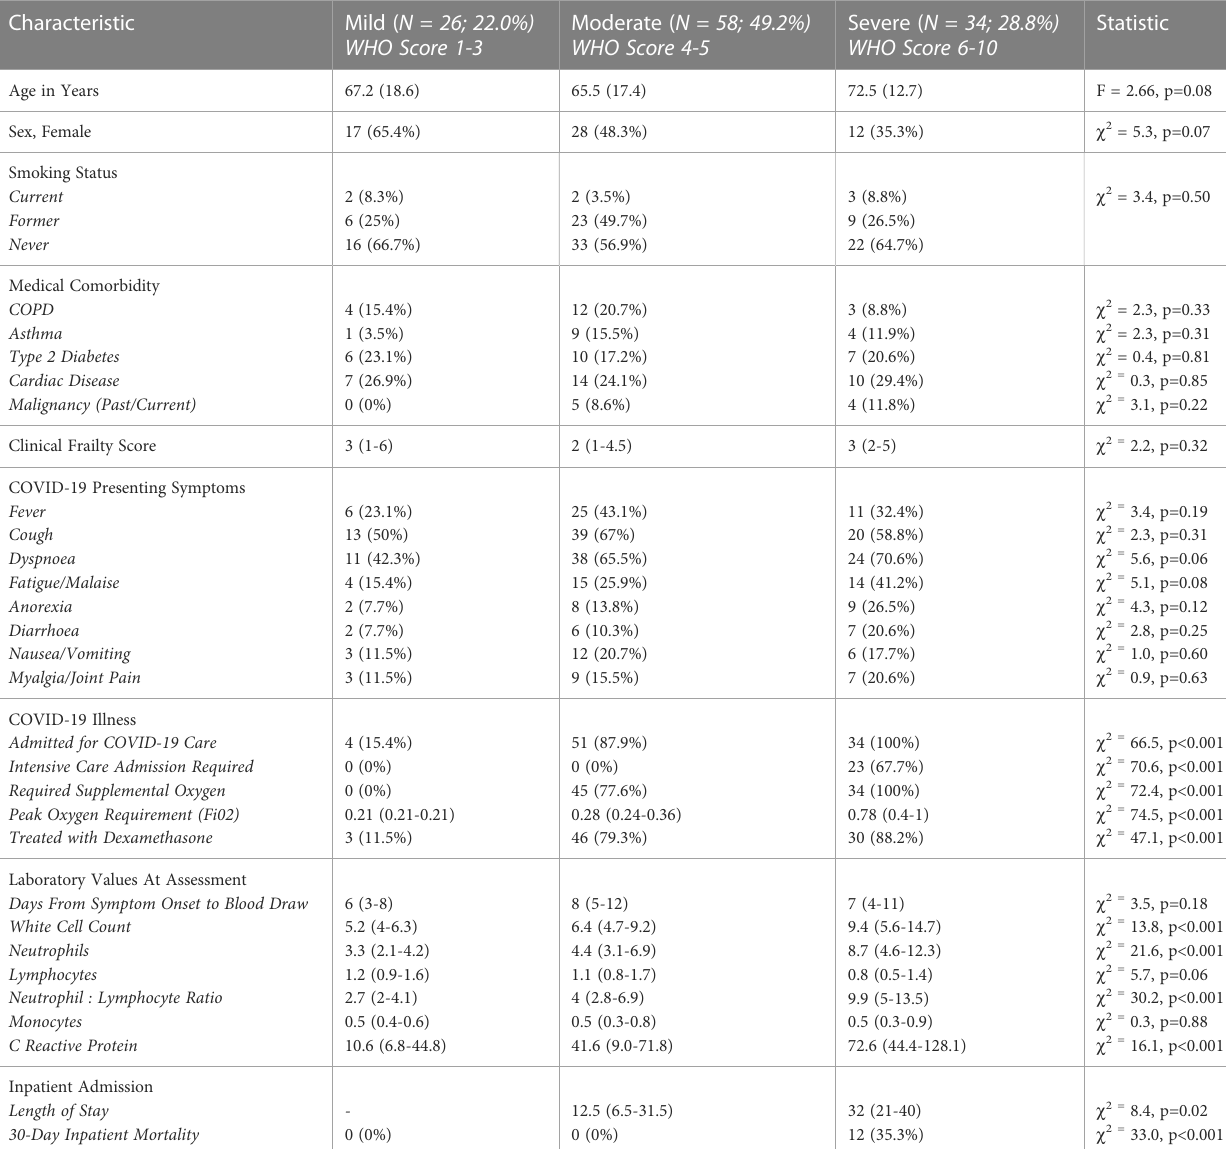
TABLE 1 Characteristics of participants (N = 118) by COVID-19 acute illness severity.